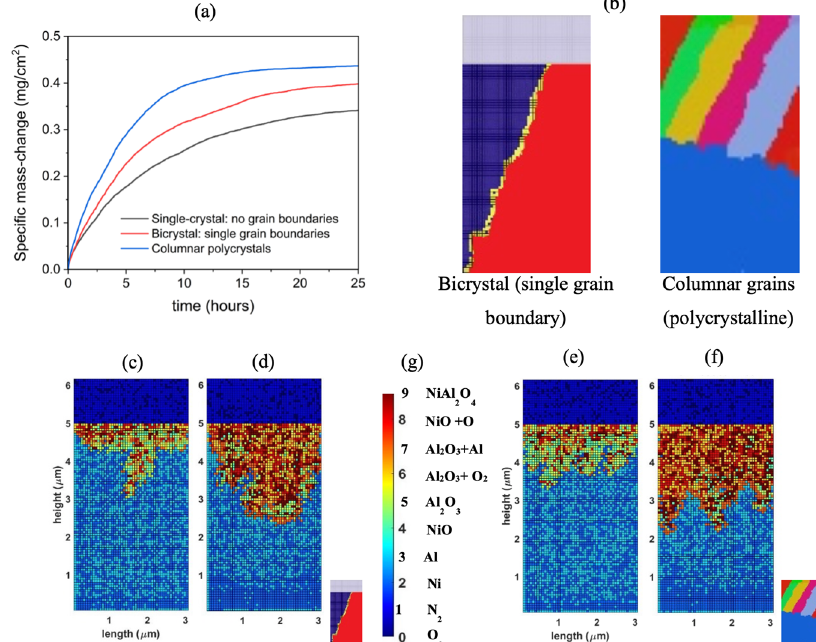
Fig. 6 Oxidation kinetics and morphology for oxidation at 1200 °C. a Oxidation kinetics showing the effect of grain boundaries at 1050 °C and b the grain morphologies examined in this study. c – f Morphology of the oxide scale after 25 h of oxidation for the single crystal, bicrystal, and polycrystal. The oxide morphology after c 4 h and d 25 h of oxidation is shown for the bicrystal sample. Likewise, the oxide scale morphology after e 4 h and f 25 h of oxidation are shown for the columnar grains. The compositional representation of different colors is illustrated on the shade index g .